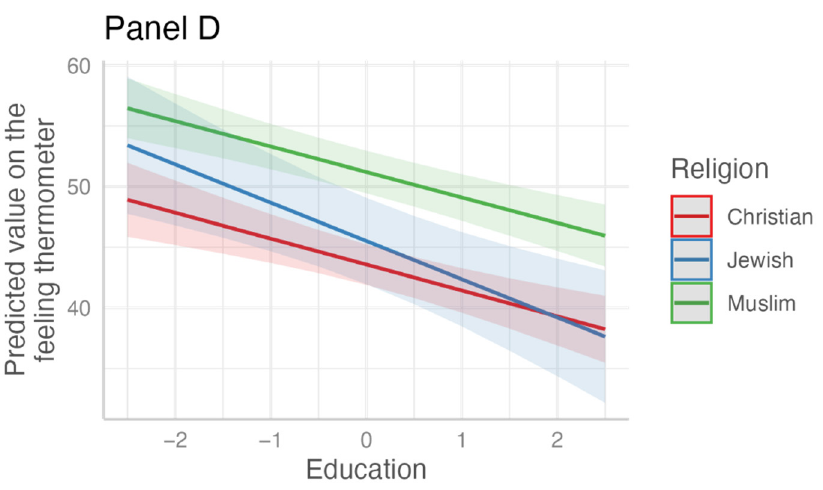
Figure 2. Predicted feeling thermometer scores for apostates conditional on the values of religious practice ( Panel A ), religious fundamentalism ( Panel B ), religious knowledge ( Panel C ), and education ( Panel D ) across religious groups .